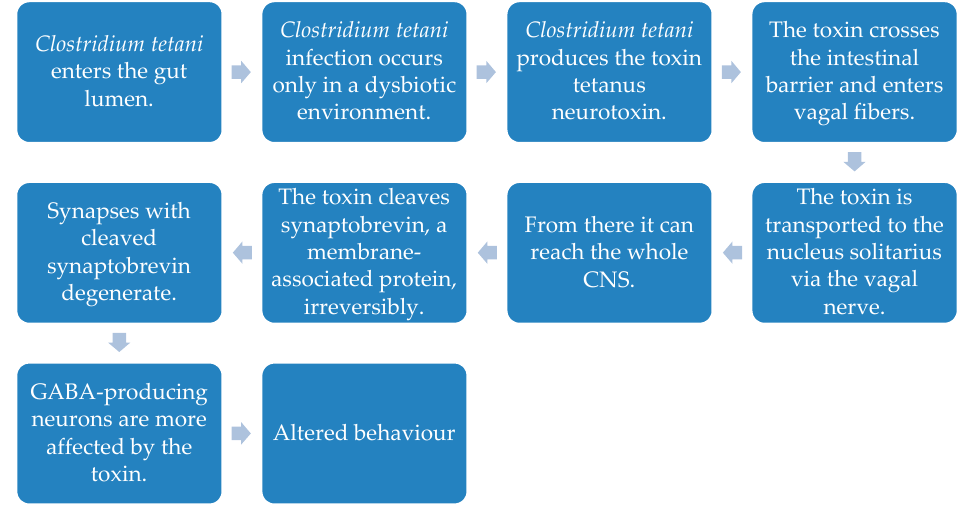
Figure 4. Process of Clostridium tetani infection in the gut. Occurrence of the bacterium Clostridium tetani in the GI tract of autistic population could lead to altered behaviour. [43].